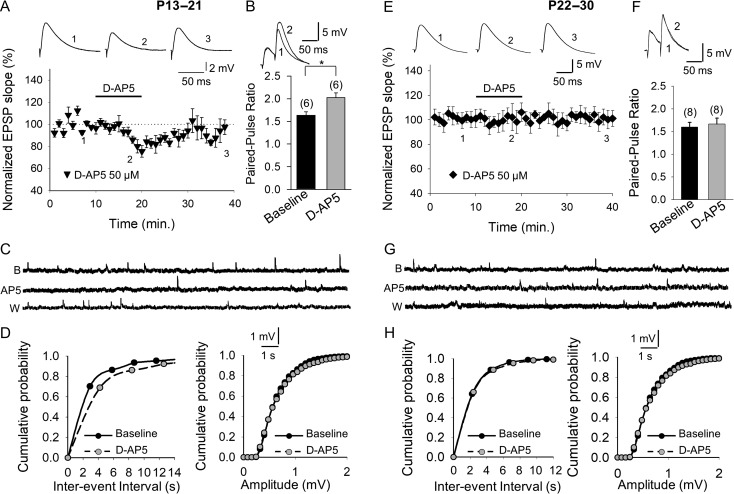
Presynaptic NMDARs are tonically active at CA3–CA1 synapses at P13–P21 but not at P22–P30. (A) With the postsynaptic neuron loaded with MK-801, the addition of D-AP5 decreases the slope of evoked EPSPs, an effect that was reversed after D-AP5 washout. The inset shows the EPSP traces at baseline (1), in the presence of D-AP5 (2) and after D-AP5 wash out (3). (B) The paired-pulse ratio increased in the presence of D-AP5. (C) Miniature EPSPs monitored during the baseline and after exposing neurons from slices of P13–P21 animals to D-AP5 in the presence of TTX (500 nM), and with the postsynaptic neuron loaded with MK-801 (1 mM). (D) Cumulative probability histograms showing that at P13–P21, D-AP5 reversibly decreases the mEPSP frequency but it does not affect the mEPSP amplitude. (E) D-AP5 does not affect the evoked EPSP slope at P22–P30. The inset shows the traces at baseline (1), in the presence of D-AP5 (2) and after D-AP5 wash out (3). (F) At P22–P30, the paired-pulse ratio is not affected by D-AP5. (G) Miniature EPSPs monitored at baseline, and during and after D-AP5 treatment of neurons from P22 to P30 mice in the presence of TTX, and with the postsynaptic neuron loaded with MK-801. (H) Cumulative probability histograms showing that D-AP5 does not affect mEPSP frequency or amplitude at P22–P30. The error bars indicate the S.E.M. and the number of slices is shown in parentheses: *P < 0.05, unpaired Student’s t-test.